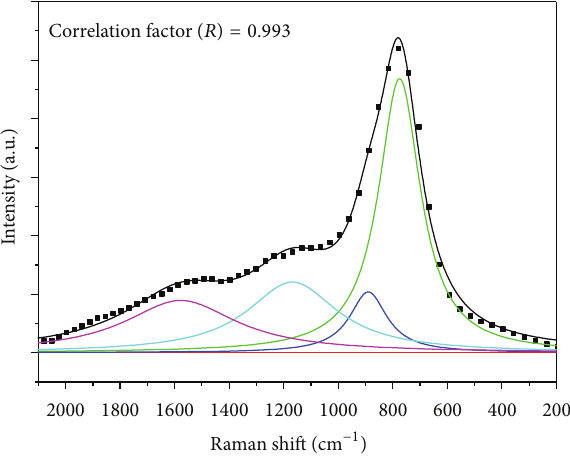
Figure 12: Raman spectrum of the cross section of sample